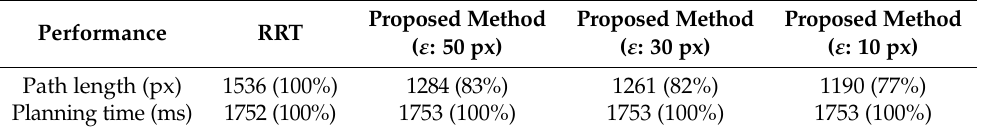
Table 5. Experimental results of Map 4 (numbers in parentheses to (averages of repeating 100 times) are relative ratios to RRT results (values less than 1 are counted as